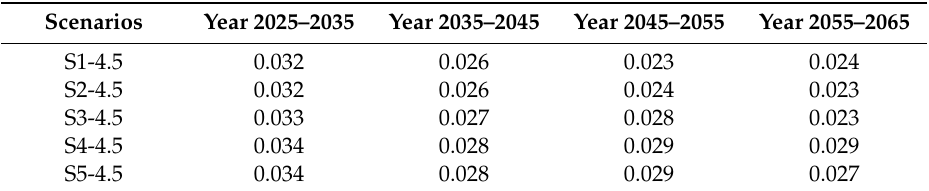
Table 9. Prediction of sediment deposition (BCM /